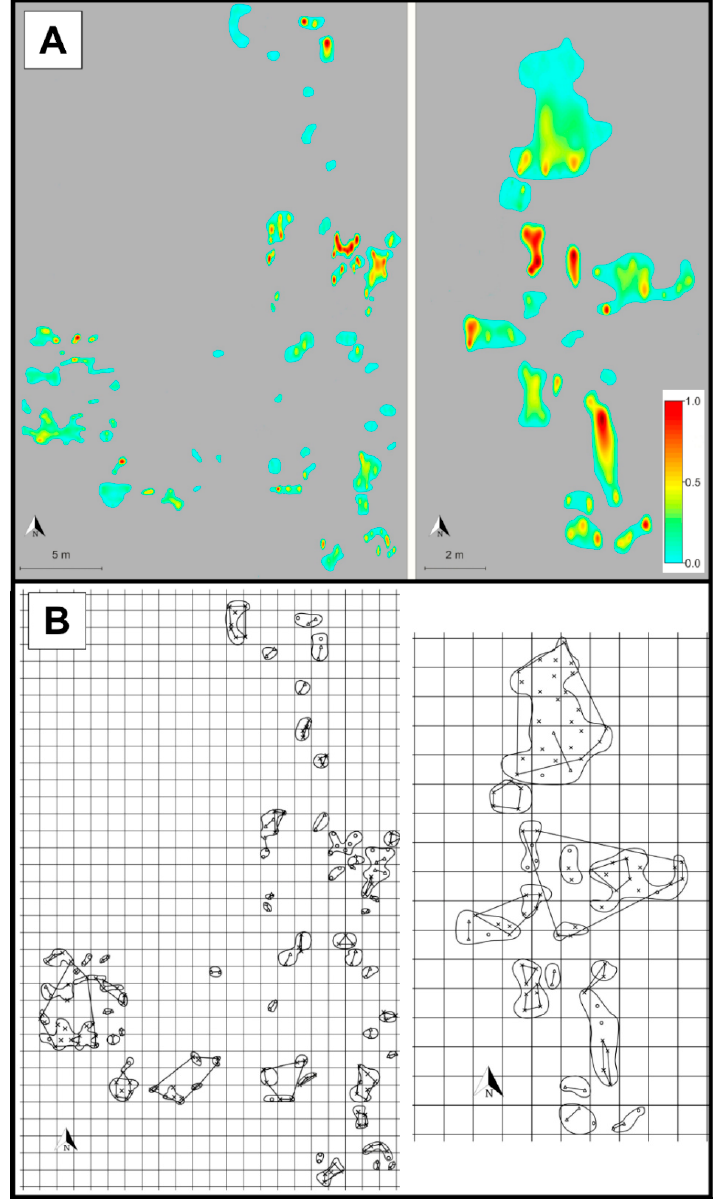
Figure 7. ( A ) Density map showing the spatial distribution of genotypic richness (given by the color scale on the right) in the population’s two remaining large groups of patches (central group on the left and northern group on the right; for better appreciation of the population’s structure, see Figure 10). The patches are colored, while the areas without S. brachyodon are in grey. Darker reddish colors indicate areas characterized by high levels of genotypic richness, while lighter greenish colors indicate areas characterized by lower levels of genotypic richness. ( B ) Spatial distribution map of the sampled S. brachyodon ramets in the population’s two large remaining groups of patches (central group on the left and northern group on the right: for better appreciation of the population’s structure, see Figure 10) shown over a 1 × 1 m resolution grid. The individual genets that comprise three or more sampled ramets are indicated by polygons, while the irregular closed shapes indicate patches of ramets. The sampled ramets that are characterized by a unique MLG are represented by circles, pairs of ramets that belong to the same genet are represented by triangles, and three or more ramets that belong to the same genet are represented by “x” mark and positioned within an associated polygon.